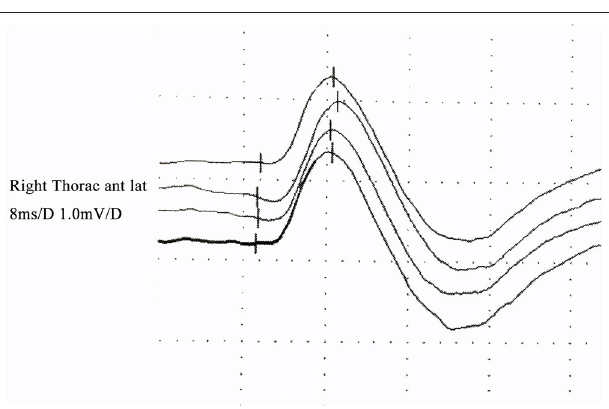
FIGURE 2 | Quantitative pectoralis tendon reflex in an FAS patient: the latency and amplitude were